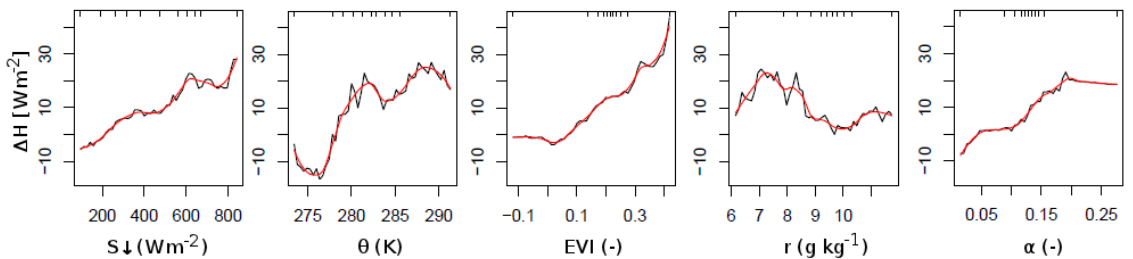
Figure 5. Environmental mean response functions for the sensible heat flux. The functions show the responses to changes in the downward shortwave solar radiation (S ↓ ), potential temperature ( θ ), enhanced vegetation index (EVI), mixing ratio ( r ), and land-surface albedo ( α ). The black line shows the variable response of the BRT and the red line is an equidistantly smoothed representation of the black line. Rug plots along the top margins of the plots show the distribution of the variables in deciles.